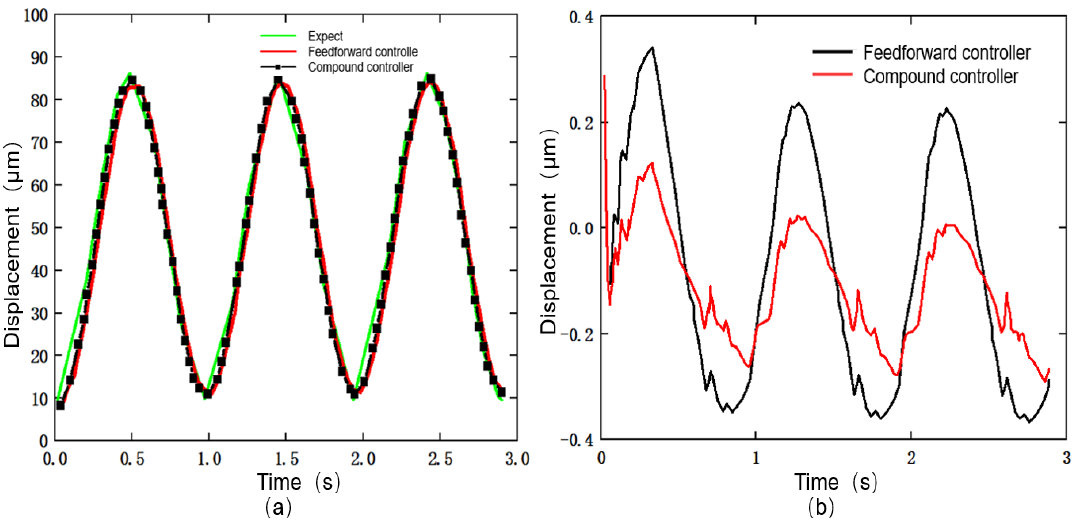
Figure 20. Comparison diagram of feedforward control and composite control effect of 40 Hz signal: ( a ) Comparison of expected displacement and actual displacement. ( b ) Error between expected displacement and actual displacement.